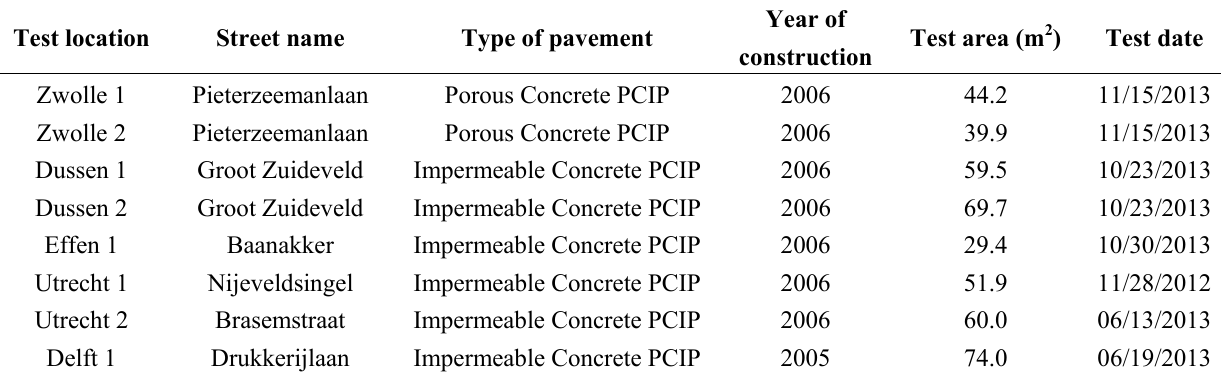
Table 1. Permeable pavement locations tested in the